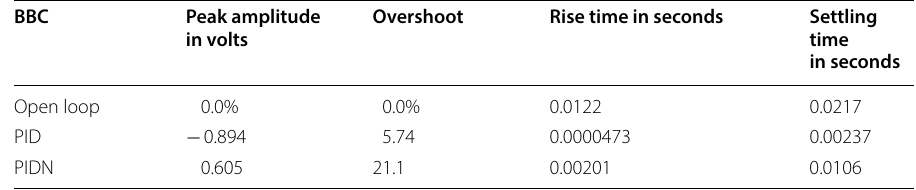
time in seconds